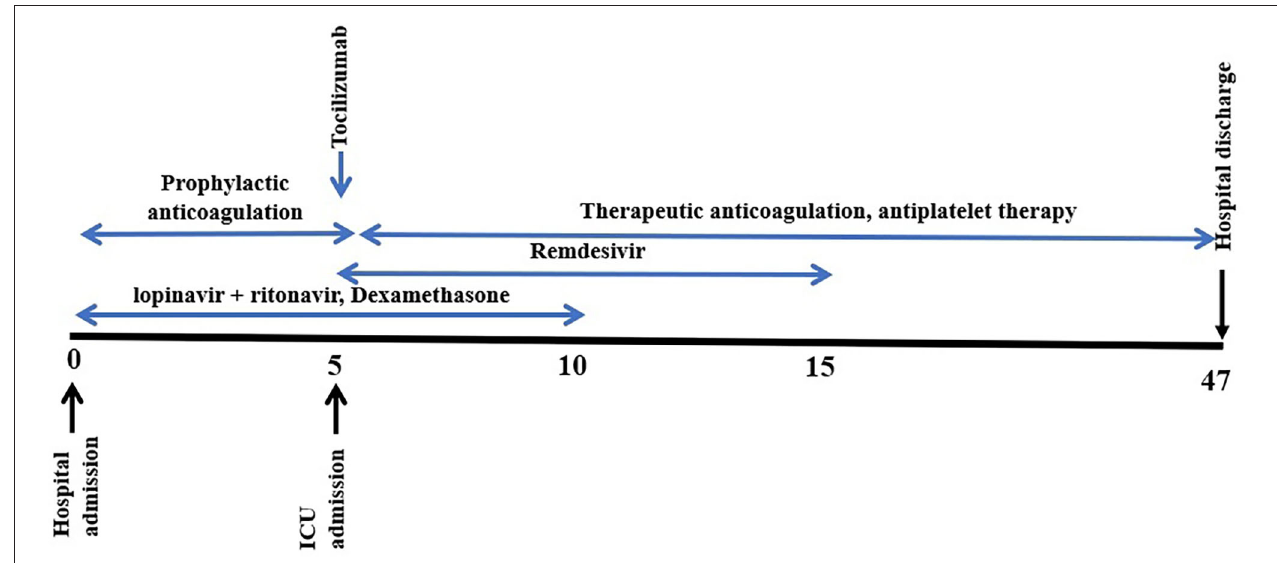
FIGURE 1 | Treatment initiation